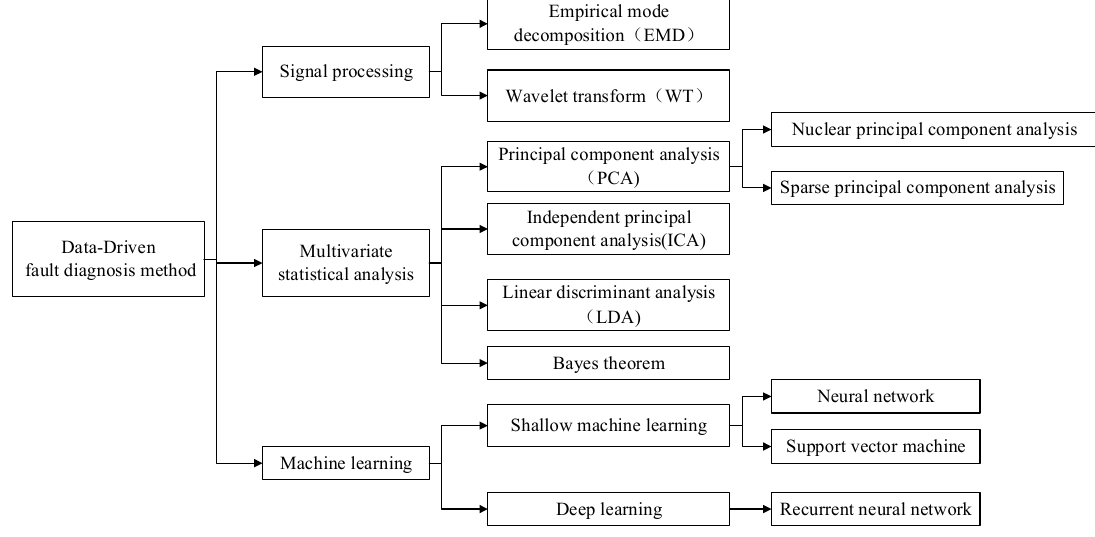
Figure 2. The data ‐ driven fault diagnosis method for chillers.